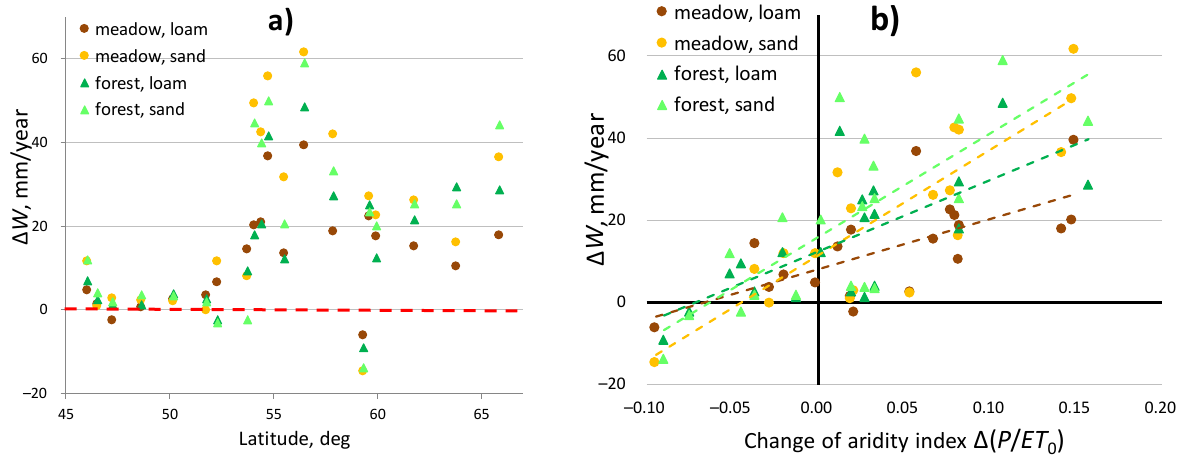
Figure 11. Modeled latitudinal changes in mean annual groundwater recharge ∆ W in modern period (a) and the relationship between ∆ W and changes in aridity index ∆ ( P / ET 0 ) (b) with general tendencies for different landscapes (dashed lines).